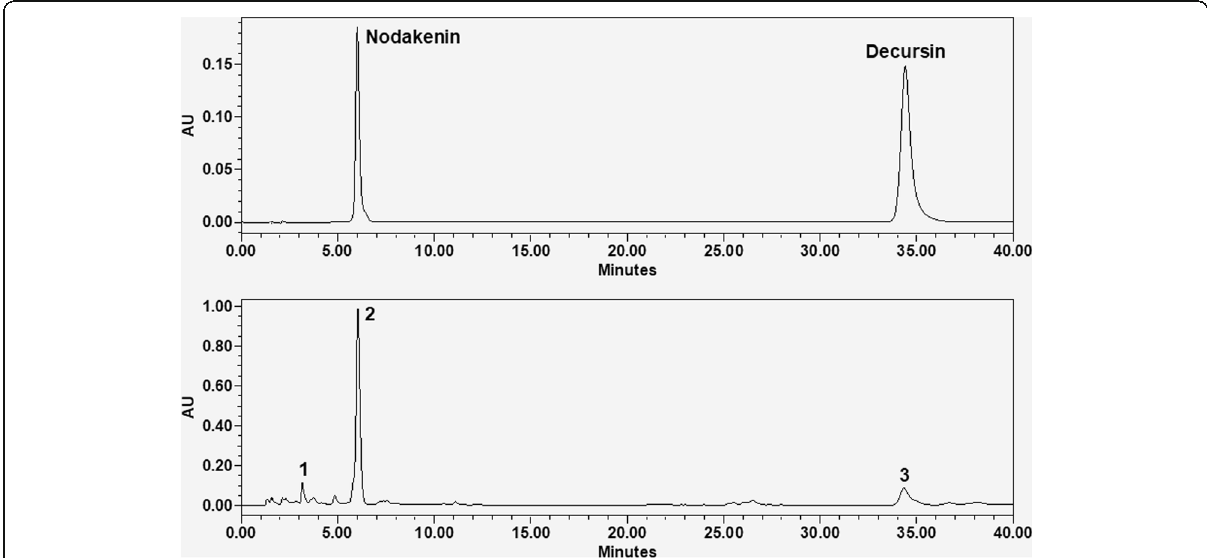
Fig. 5 Qualitative and quantitative HPLC analysis of standard materials in ADE. The retention time of the peak 1, peak 2 (nodakenin), peak 3 (decursin) was 3.2, 6.1, and 34.4 min,